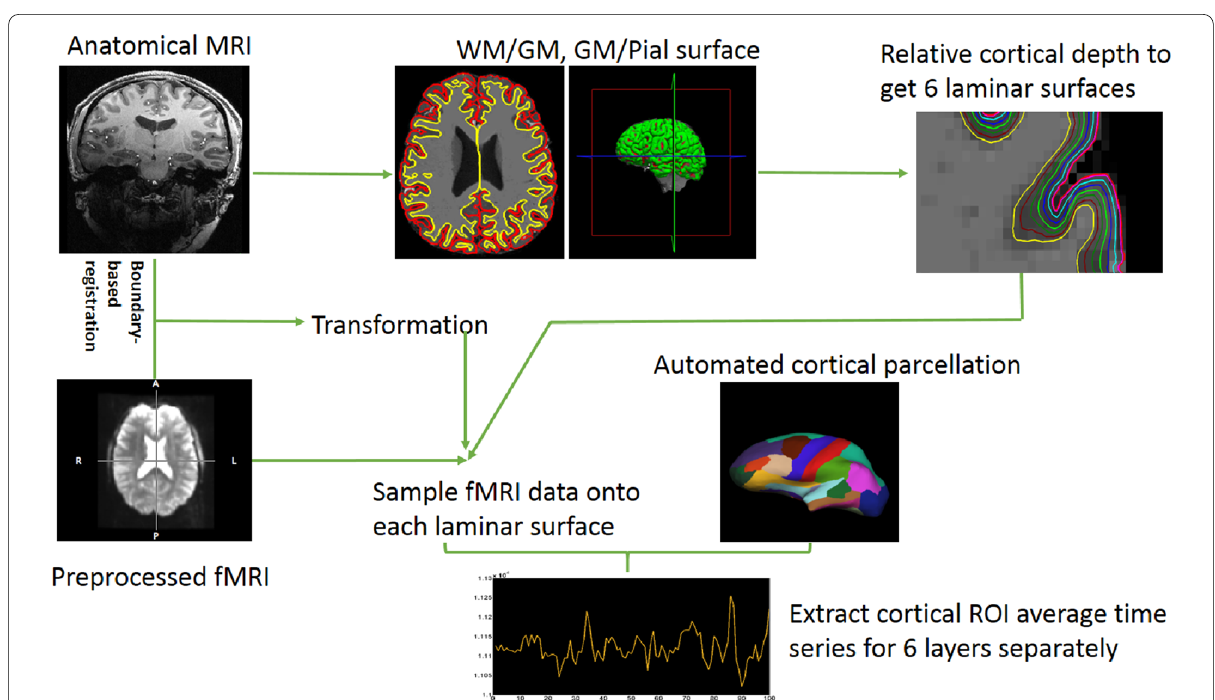
Fig. 2 Schematic illustrating the laminar analysis pipeline for extracting mean time series from the six cortical layers for all 68 brain regions in the Desikan–Killiany atlas